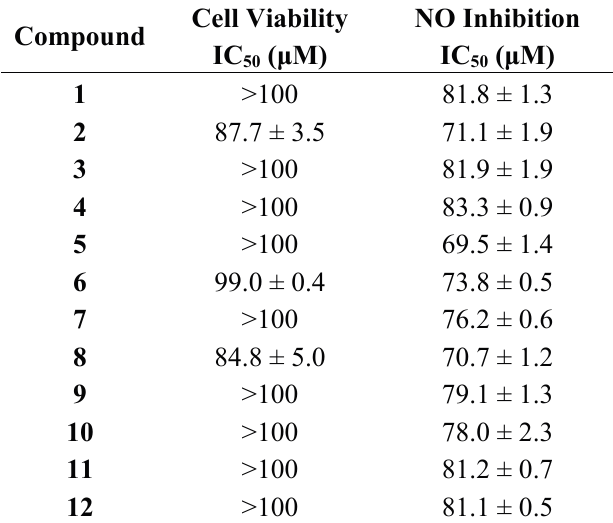
Table 2. Inhibitory effects of Compounds 1 – 12 against lipopolysaccharide-induced nitric oxide production in RAW 264.7